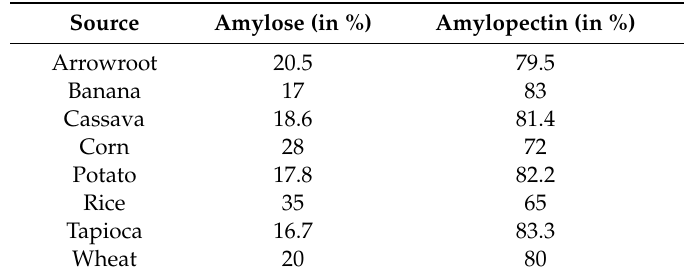
Table 1. Amylose and amylopectin concentration of various starch